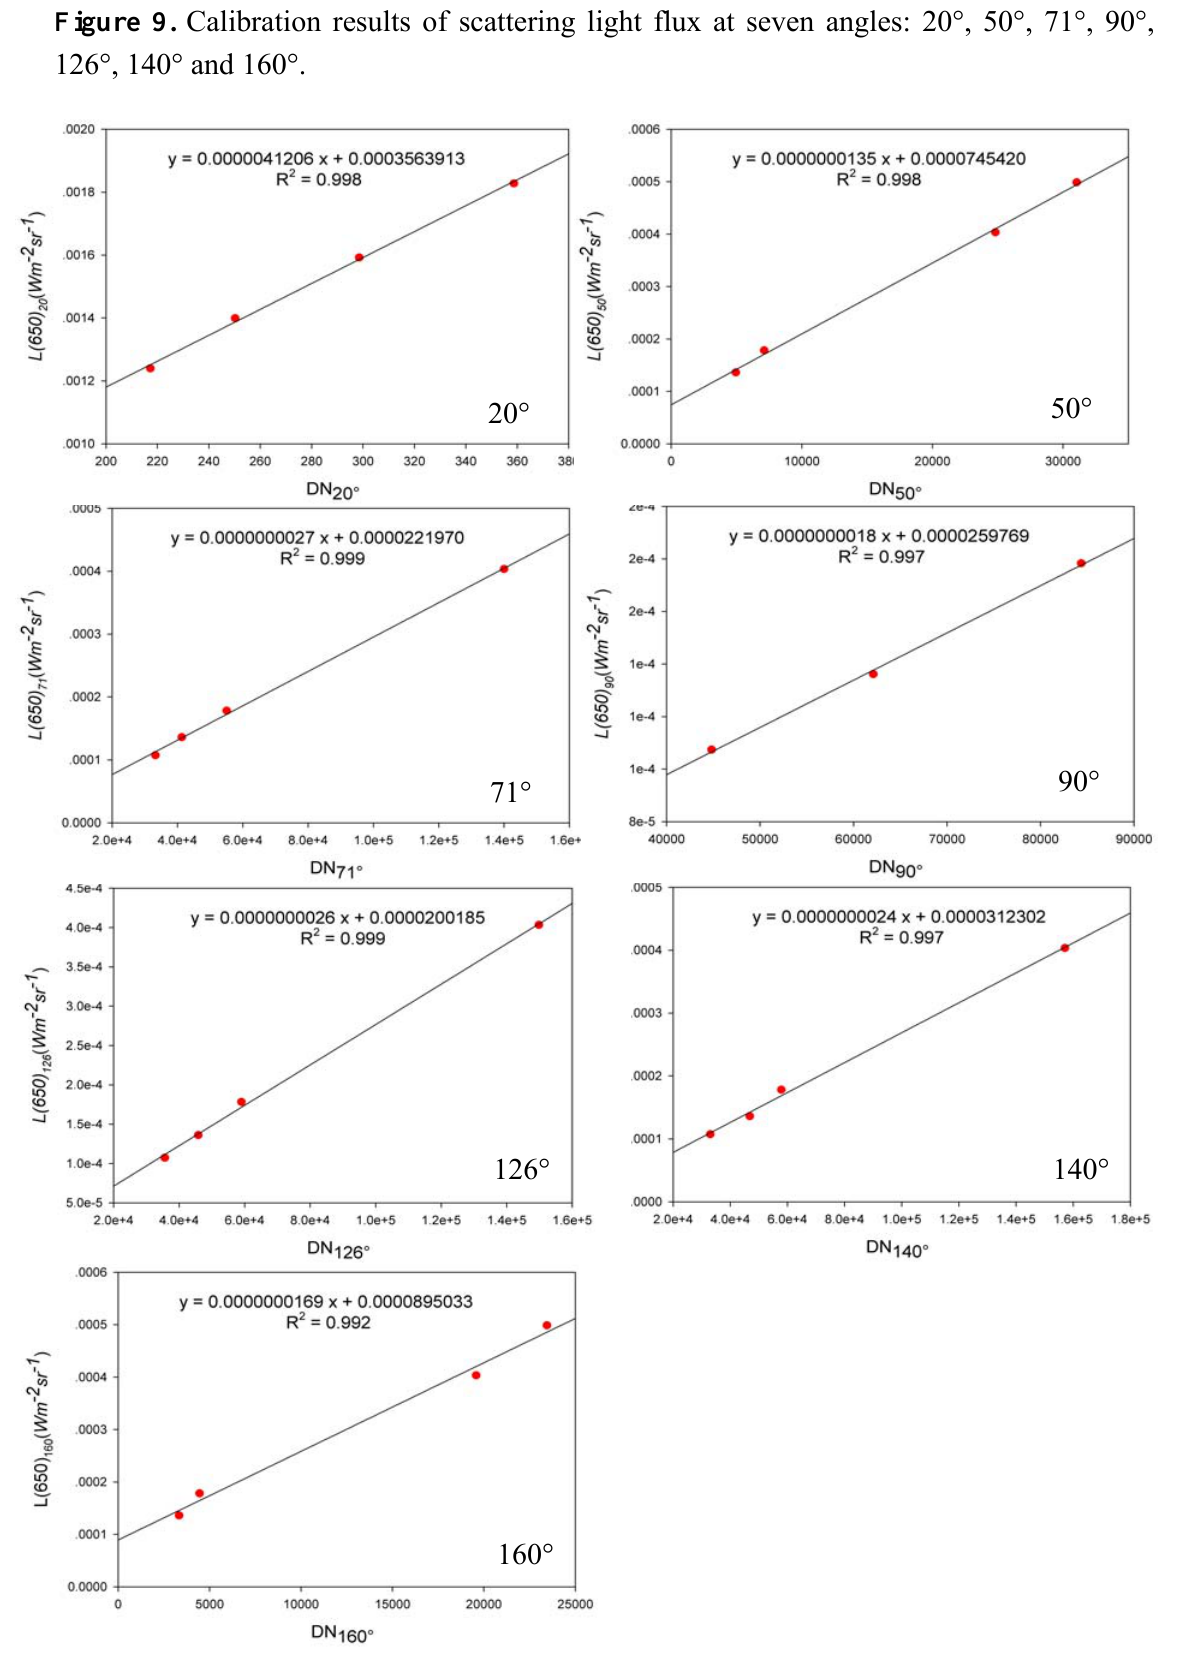
Figure 9. Calibration results of scattering light flux at seven angles: 20°, 50°, 71°, 90°, 126°, 140° and